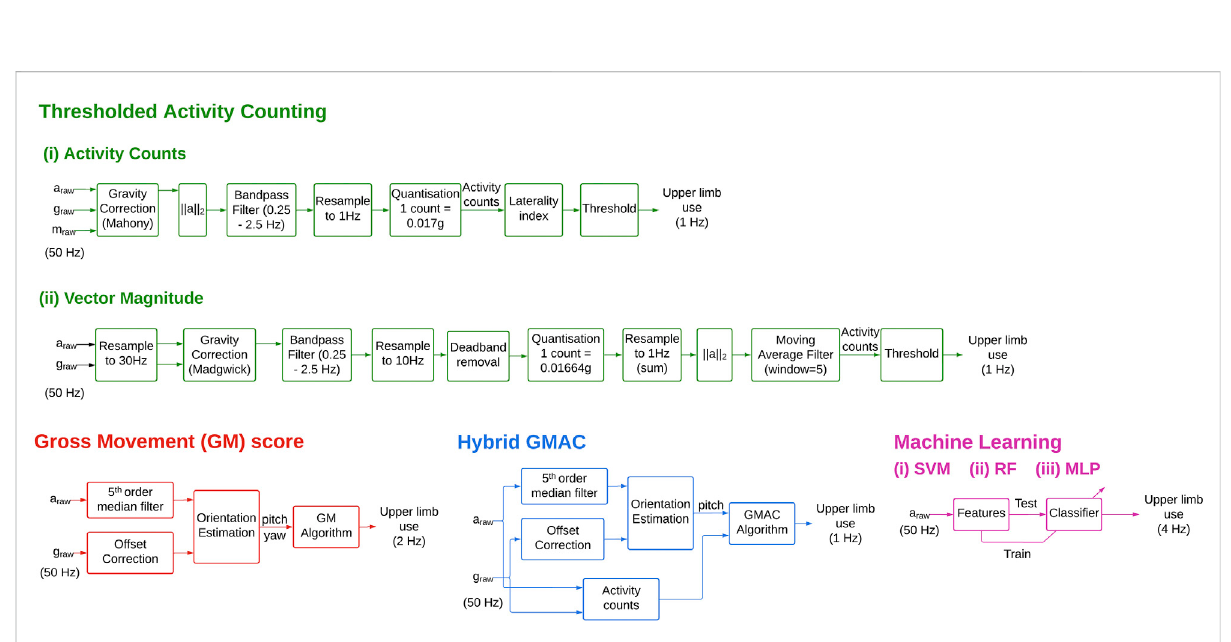
FIGURE 2 Block diagrams for the different UL use measures. These different blocks depict the essential steps involved algorithm. The details of the implementation of these steps can be found in the shared code